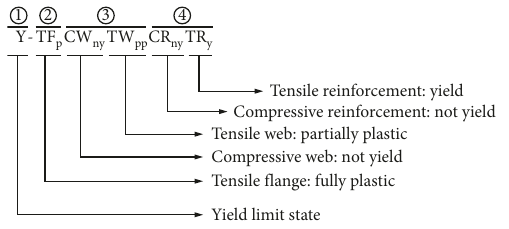
Figure 2: Definition of a stress